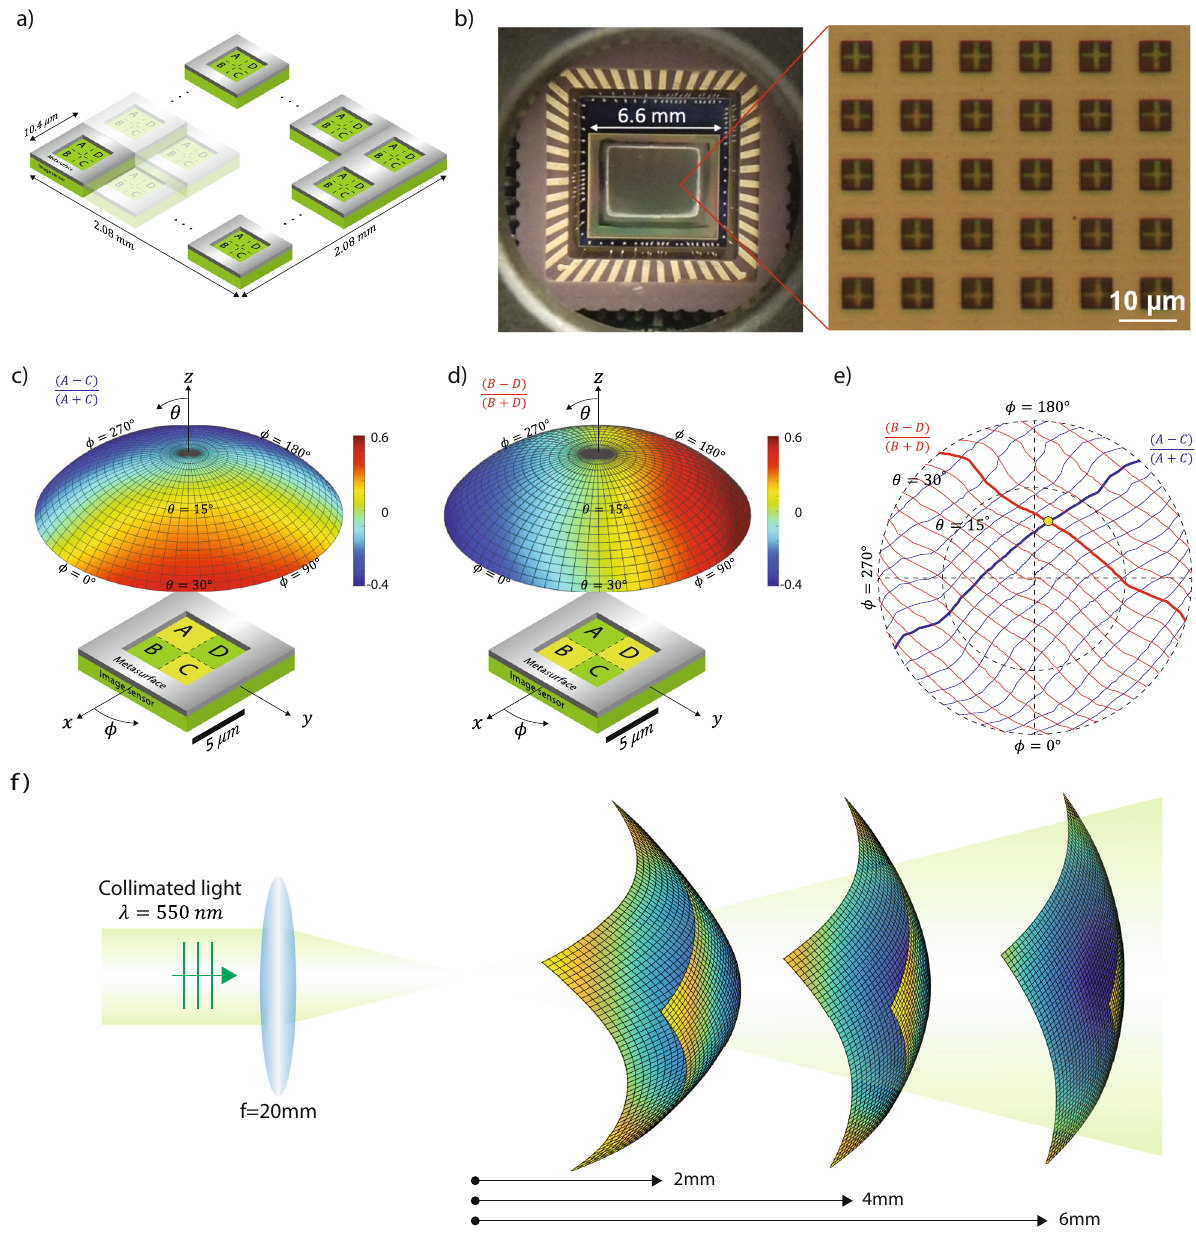
Fig. 3 Wavefront sensor fabrication and characterization. a Schematic of a wavefront sensor that consists arrays of unit cell. Each unit cell consists of 2 × 2 pixels. b Image of a fabricated wavefront sensor and a microscope image showing its local region where 2 × 2 pixels are partially exposed under each aperture. c Measured pixel intensity ratio ð A (cid:1) C Þ ð A þ C Þ of one unit cell as a function of incident angle shown on a hemisphere. Each point on the hemisphere represents one combination of polar angle θ and azimuthal angle ϕ . d Measured pixel intensity ratio ð B (cid:1) D Þ ð B þ D Þ of one unit cell as a function of incident angle shown on a hemisphere. e Contour lines extracted from the hemisphere in c and d . A unique incident angle can be determined when two ratios ð A (cid:1) C Þ ð A þ C Þ and ð B (cid:1) D Þ ð B þ D Þ are measured by the four photodetectors. f Measurement of a diverging wavefront at three different locations that are 2, 4, and 6 mm away from the focal point. Each grid point represents a measured data. It can be seen that the wavefront is characterized at a high spatial